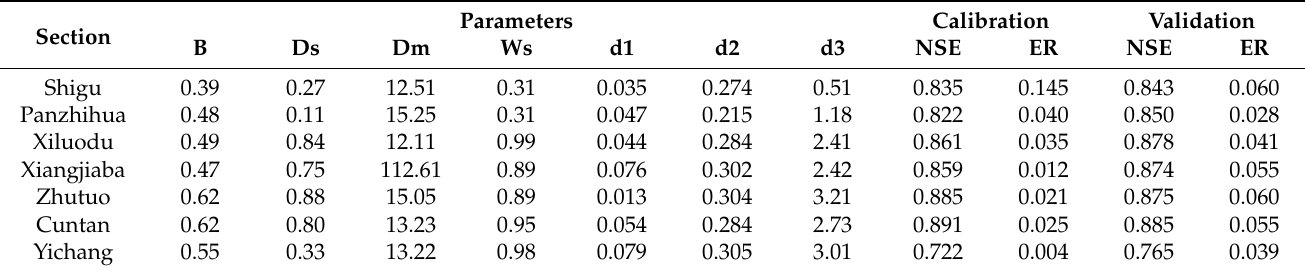
Table 1. Parameters, NSE, and total error (ER) of VIC model in calibration and validation. Section